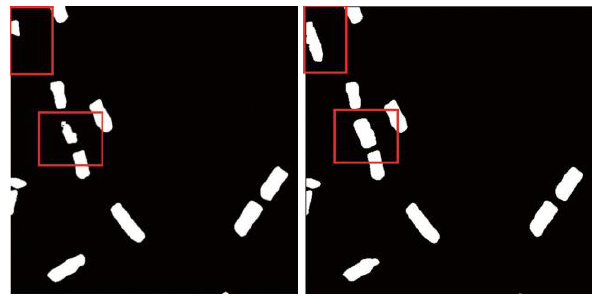
Fig.5 Original satellite images and building extraction results